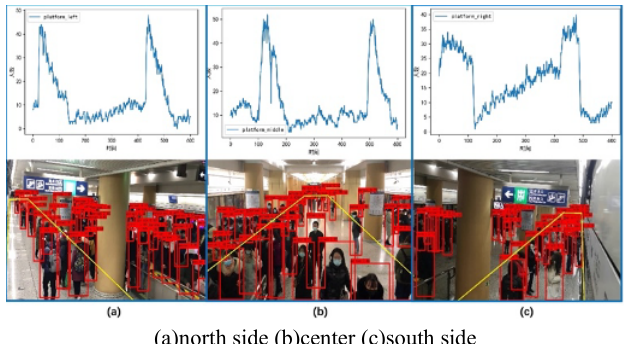
Fig. 2. The personnel identification of subway station